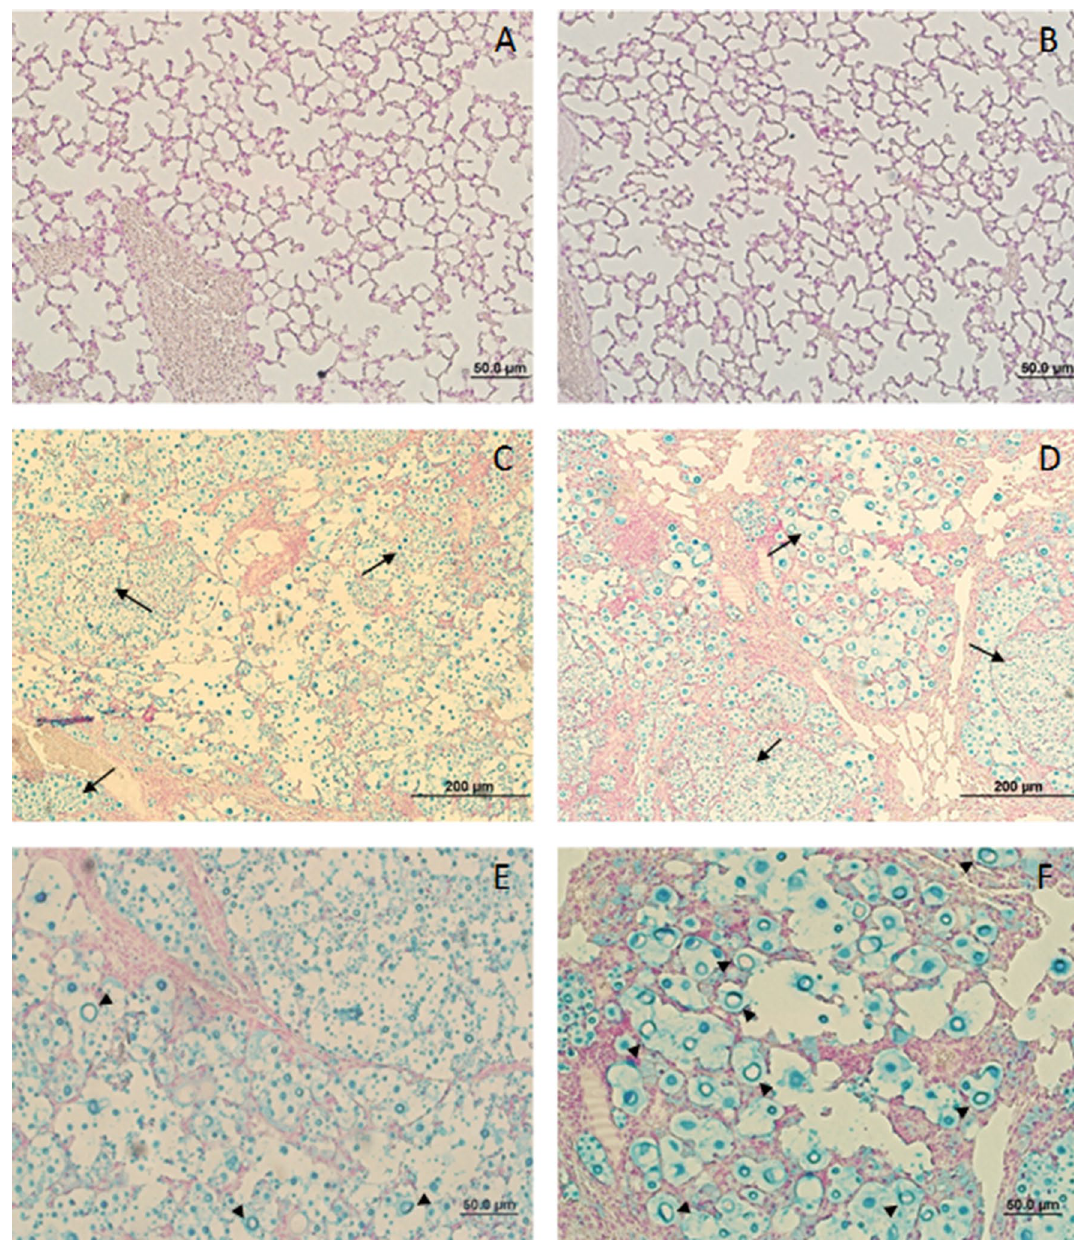
Figure 3. Histological sections of lungs of C. gattii -infected WT and TLR9 −/− animals. Micrographs of histological sections of lungs obtained from WT and TLR9 −/− animals infected with C. gattii after 21 days ( C – F ) or given sterile PBS (Sham) ( A , B ). In the left column, the histological sections of the lungs of WT mice ( A , C , E ) (n = 3). In the right column, histological sections of the TLR9 −/− mice ( B , D , F ) (n = 4). Magnification, ×40 ( A – D ); Magnification ×100 ( E , F ). The arrows show normal C. gattii yeasts and the arrowheads show C. gattii titan cells in the lungs of both WT and TLR9 −/− mice. The histological sections were stained with hematoxylin, eosin and Alcian Blue and photographed under a light